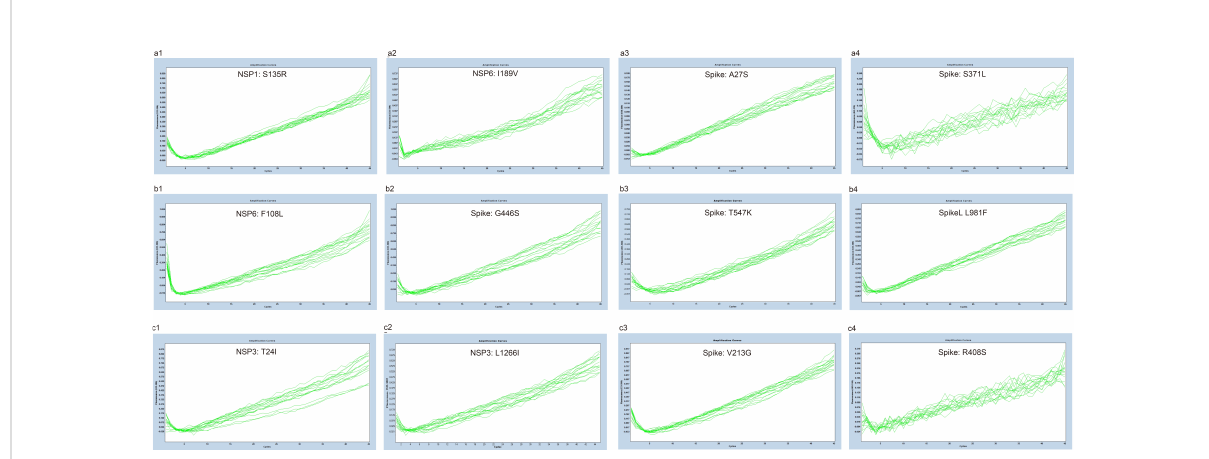
FIGURE 6 Evaluation of cross-reactivity between the developed assays and common respiratory viruses and pathogenic bacteria. The nucleic acids from the other coronaviruses (including NL63, OC43 and 229E), other respiratory viruses (including in fl uenza viruses, parain fl uenza viruses, and respiratory syncytial virus) and pathogenic bacteria (including Streptococcus pneumoniae , Haemophilus in fl uenzae , Staphylococcus aureus and Pseudomonas aeruginosa ) were used as templates (n=16) to check the cross-reactivity between the developed assays and common respiratory pathogens. The ampli fi cation curves for assay 1 [NSP1: S135R (a1), NSP6: I189V (a2), Spike: A27S (a3), and Spike: S371L (a4)], assay 2 [NSP6: F108L (b1), Spike: G446S (b2), Spike: T547K (b3) and Spike: L981F (b4)], assay 3 [NSP3: T24I (c1), NSP3: L1266I (c2), Spike: V213G (c3), and Spike: R408S (c4)] are shown.